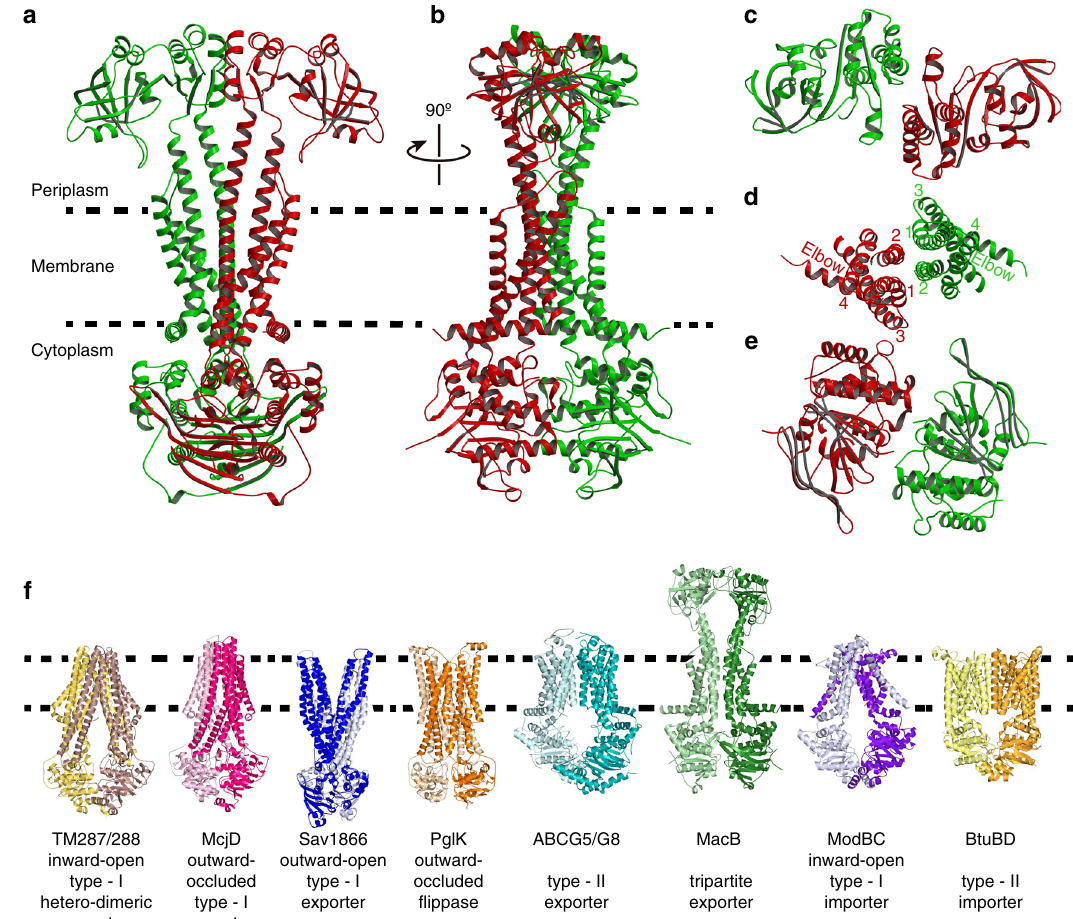
Fig. 2 Crystal structure of MacB in ribbon representation. a , b MacB homodimer viewed parallel to the membrane plane in two orientations, rotated by 90° around a vertical axis to the membrane plane. The two protomers are individually coloured (red and green). Dotted lines depict the approximate membrane boundaries on the basis of the hydrophobicity of the protein surface and position of the elbow helix (Supplementary Fig. 3). c Top view on PLD domains from periplasmic space. d Cut view of the TMD parallel to the membrane plane. TMs are numbered. e Bottom view on NBDs from cytoplasm. f Comparison with major classes of ABC transporters in different states shows that the MacB structure (in green) is unique. From left to right: type-I (B-family) exporter TM287/288 heterodimer from Thermotoga maritima in inward-open state (PDB accession code 3QF4) 11 , type-I (B-family) exporter McjD from E. coli in outward-occluded state (PDB accession code 4PL0) 12 , type-I (B-family) exporter Sav1866 from Staphylococcus aureus in outward-open state